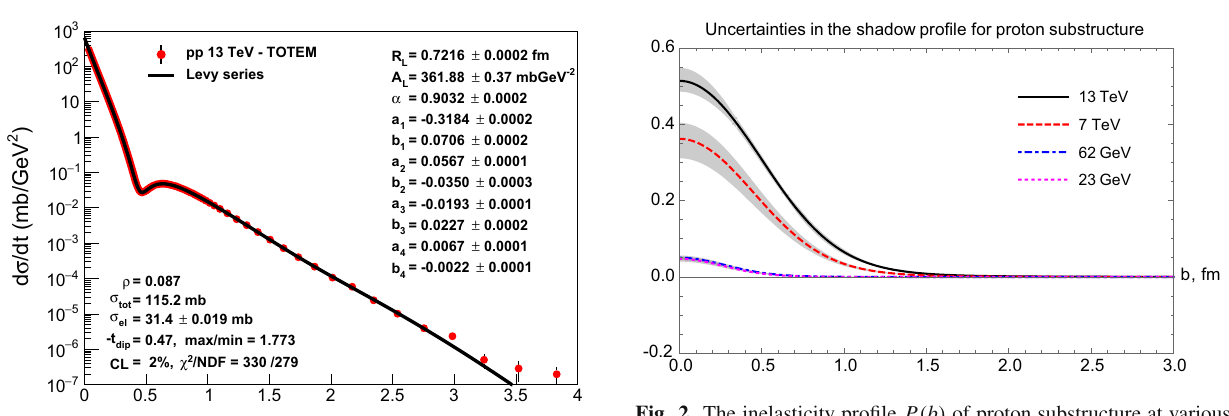
Fig. 2 The inelasticity profile P ( b ) of proton substructure at various √ s (with error bars). Here, only the secondary diffractive cone beyond the dip-and-bump structure is concerned